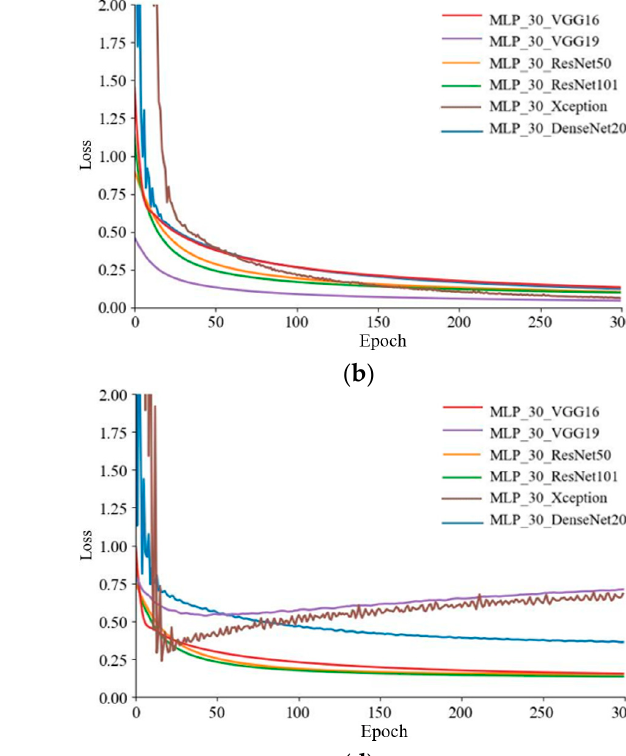
Figure 8. MLP model built with ten sets of hidden layer node numbers with VGG16 and MLP_ResNet50 fusion modeling of accuracy and F1.